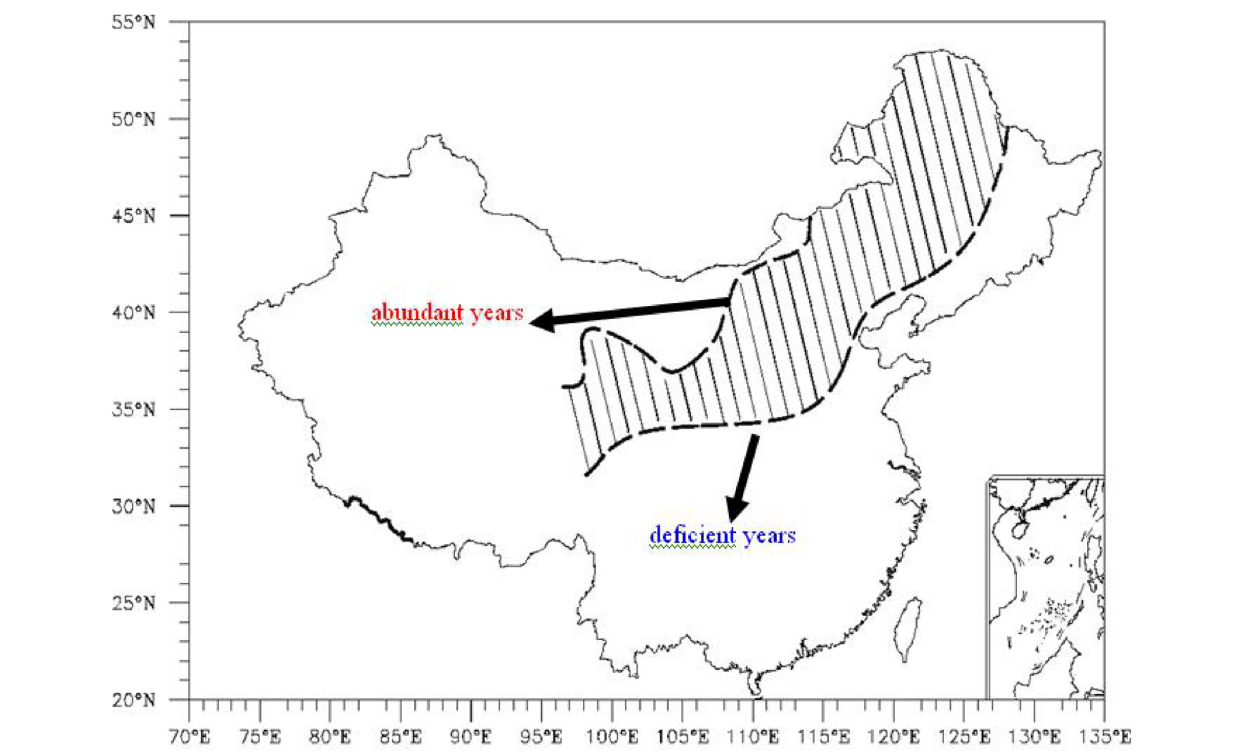
FIGURE 1 | Distribution of the summer monsoon transition zone in China (the area marked by the oblique line represents the summer monsoon transition